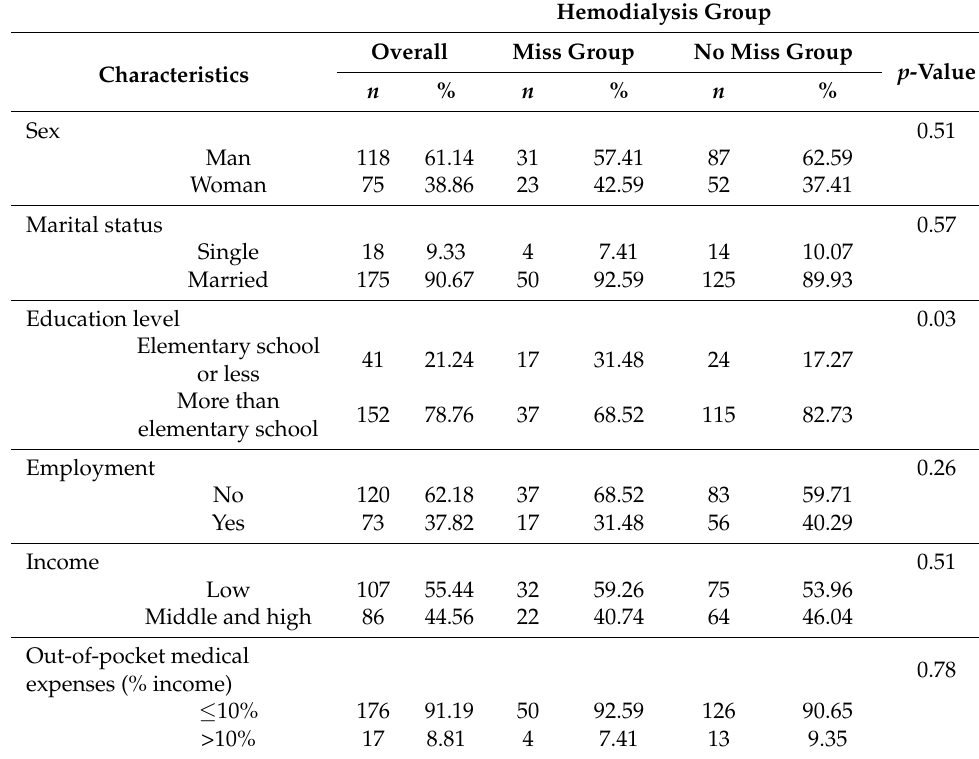
Table 1. The study participants’ characteristics ( N = 193).